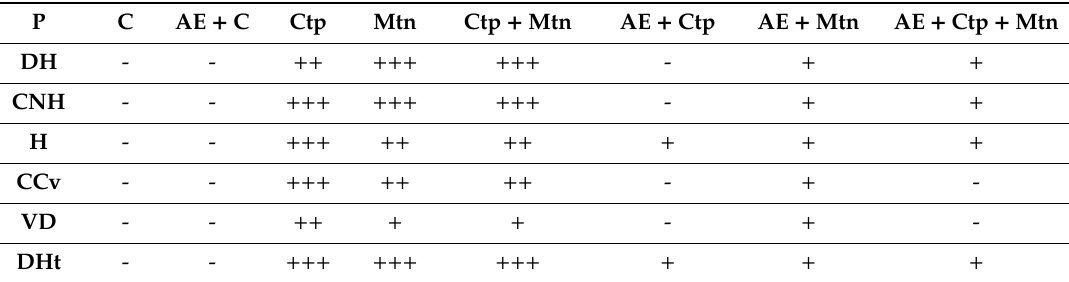
Table 4. E ff ect of cartap and malathion as well as A. vera extract on the levels of change in normal architectural of rat liver in the di ff erent treatment